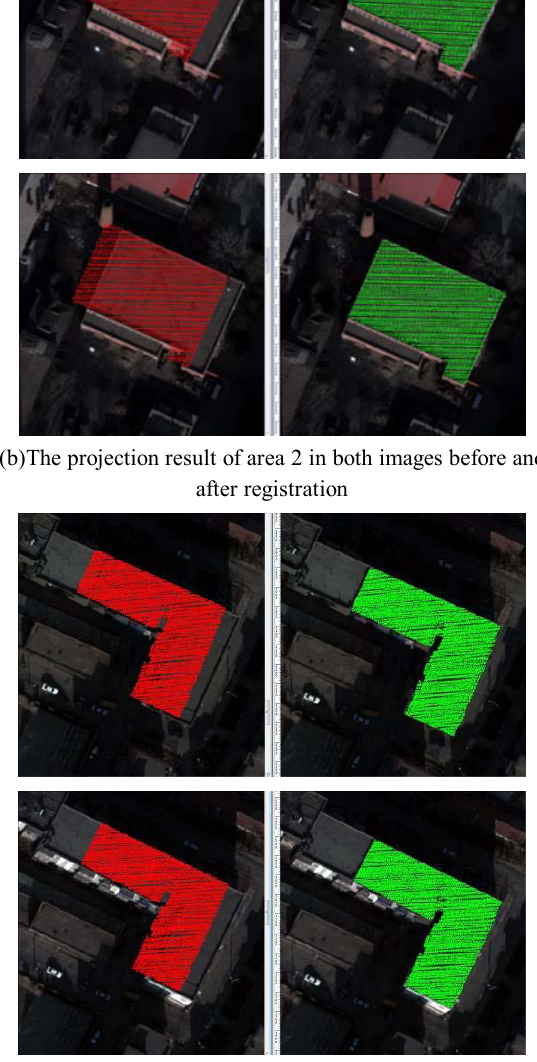
Figure.7 Back-projection results of before and after registration From above figures, it is obvious that the point cloud data and images with an obvious matching deviation turn into accurate registration after co-registration based on combined adjustment.